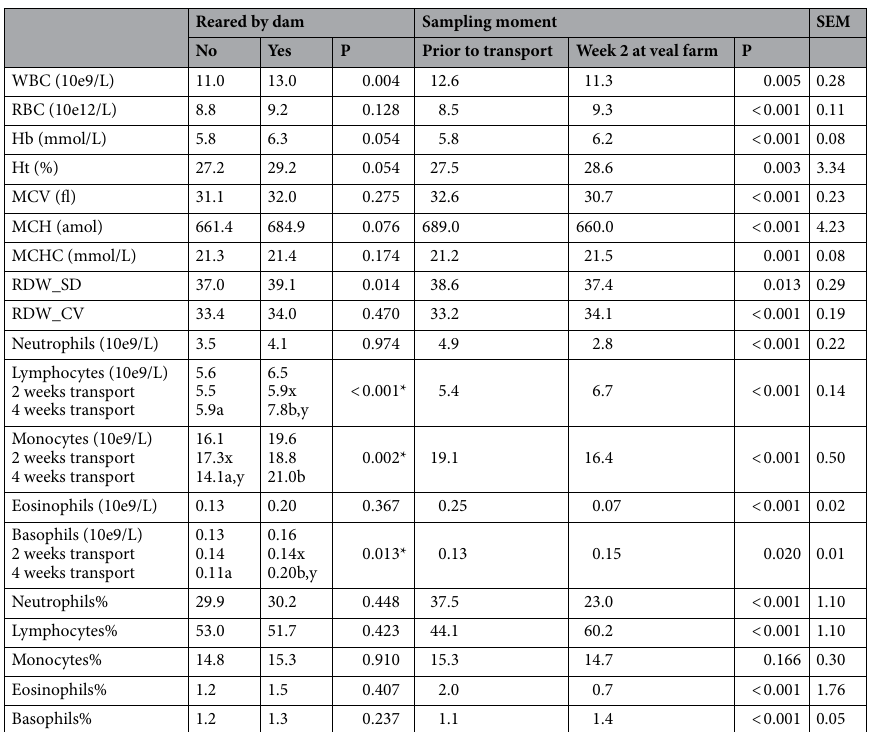
Table 5. Statistical output (raw means, P-values and SEM) for the haematological profile of calves reared with their dam or separated at birth, measured the day prior to transport and in week 2 at the veal farm. SEM is calculated across all data for that variable, regardless of treatment. Where the interaction between rearing practice and transport age was significant (P ≤ 0.05), the means are shown per transport age. WBC = white blood cells (10e9/l); RBC = red blood cells (10e12/l)); Hb = haemoglobin (mmol/l); Ht = haematocrit; MCV = mean corpuscular volume (fl);MCH = mean corpuscular haemoglobin (amol);MCHC = mean x transport age was significant (P ≤ 0.05): a-b indicates differences between rearing treatments while x–y indicates differences between transport ages.